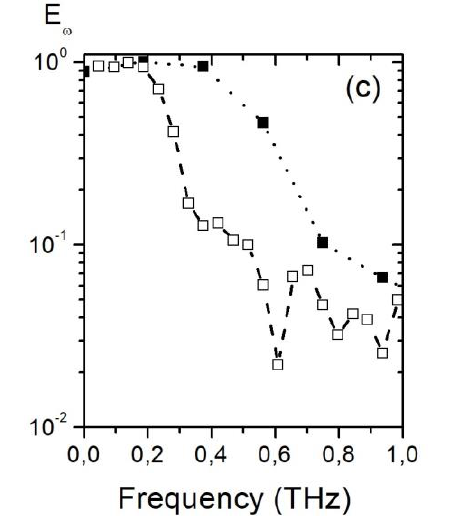
Fig. 3 Spectrum of zero-voltage signal (hollow squares) and spectrum of half-sum of signals at external bias (filled